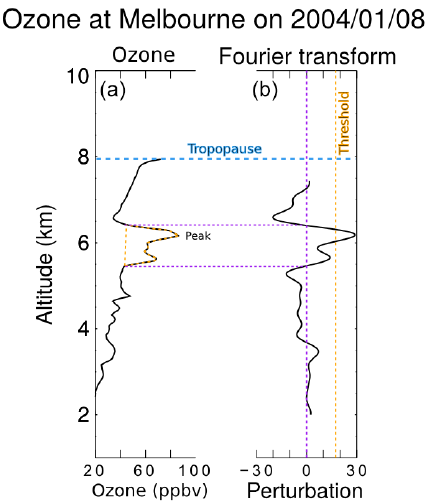
Figure 4. An example of the STT identification and flux estimation methods used in this work. The left panel shows an ozone profile from Melbourne on 8 January 2004 from 2km to the tropopause (blue dashed horizontal line). The right panel shows the perturba- tion profile created from bandpass filtering of the mixing ratio pro- file. The STT occurrence threshold calculated from the 95th per- centile of all perturbation profiles is shown as the orange dashed line, and the vertical extent of the event is shown with the purple dashed lines (see details in text). The ozone flux associated with the STT event is calculated using the area outlined with the orange dashed line in the left